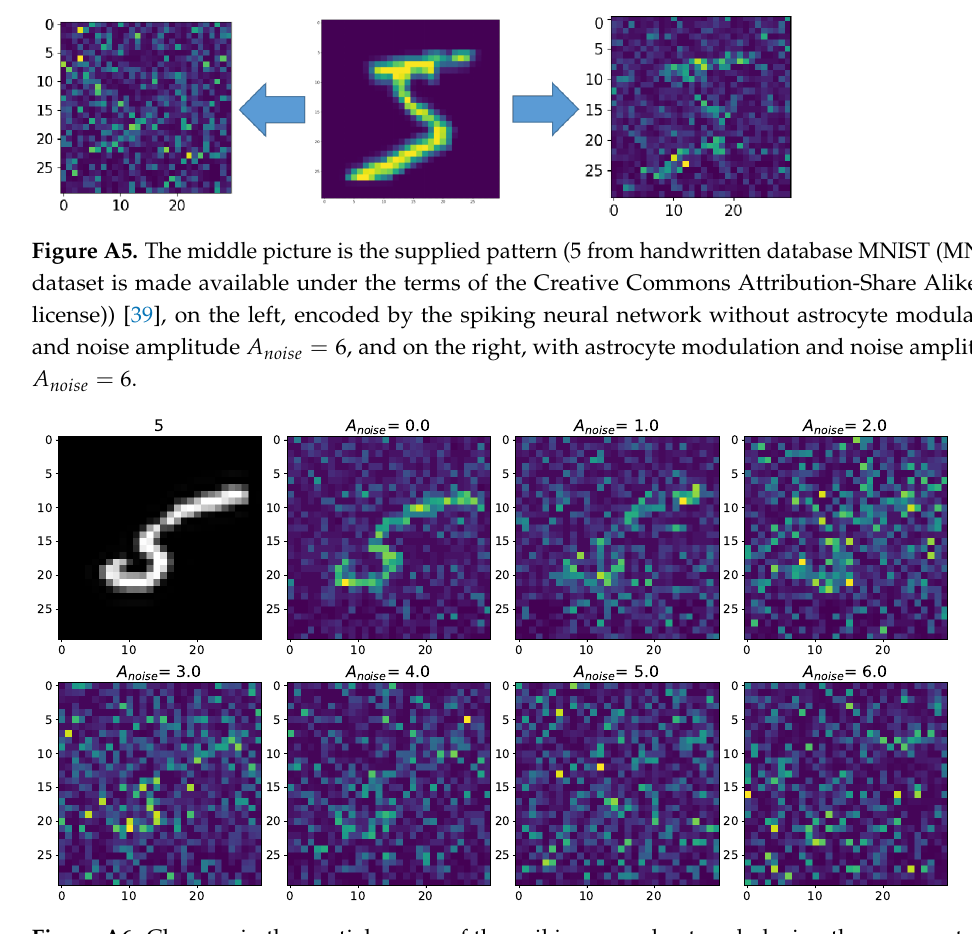
Figure A6. Changes in the spatial sweep of the spiking neural network during the representation of the supplied image from the Figure A5 when the amplitude, A noise , of the noise current, I noise , changes from 0 to 6 without modulation of neuronal activity by astrocytes.